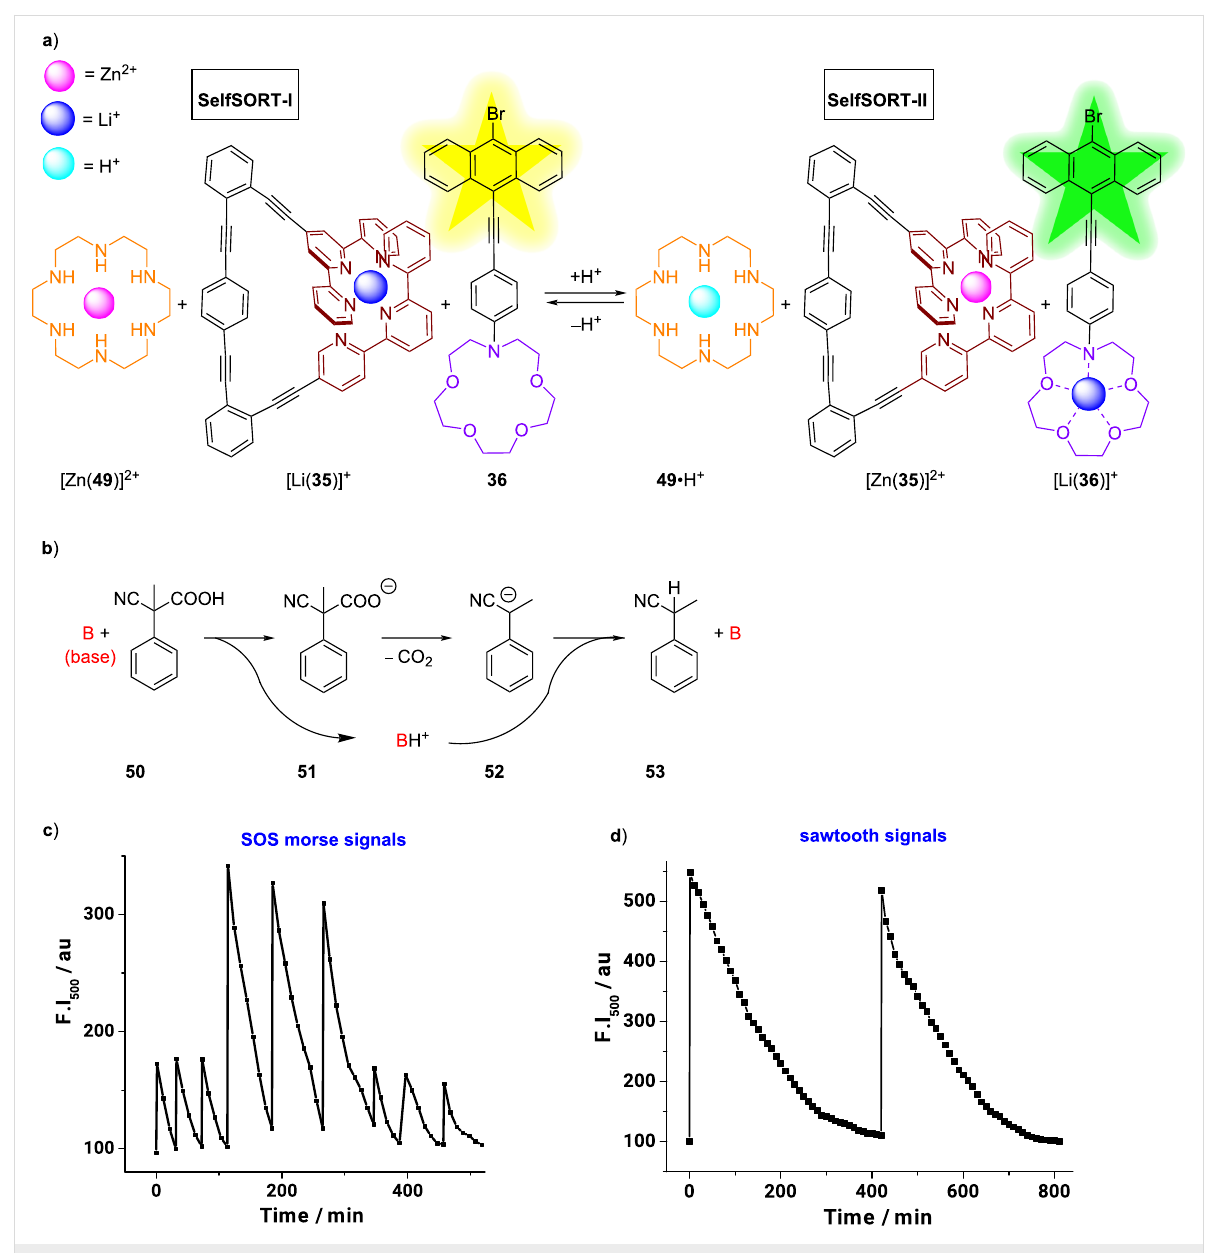
Figure 15: a) The chemically fueled cascaded ion translocation, monitored by distinct emission colors. b) Working principle of the chemical fuel 50 . Off-equilibrium lithium pulses generate c) SOS morse signals, and d) sawtooth signals. Adapted with permission from (Ghosh, A.; Paul, I.;